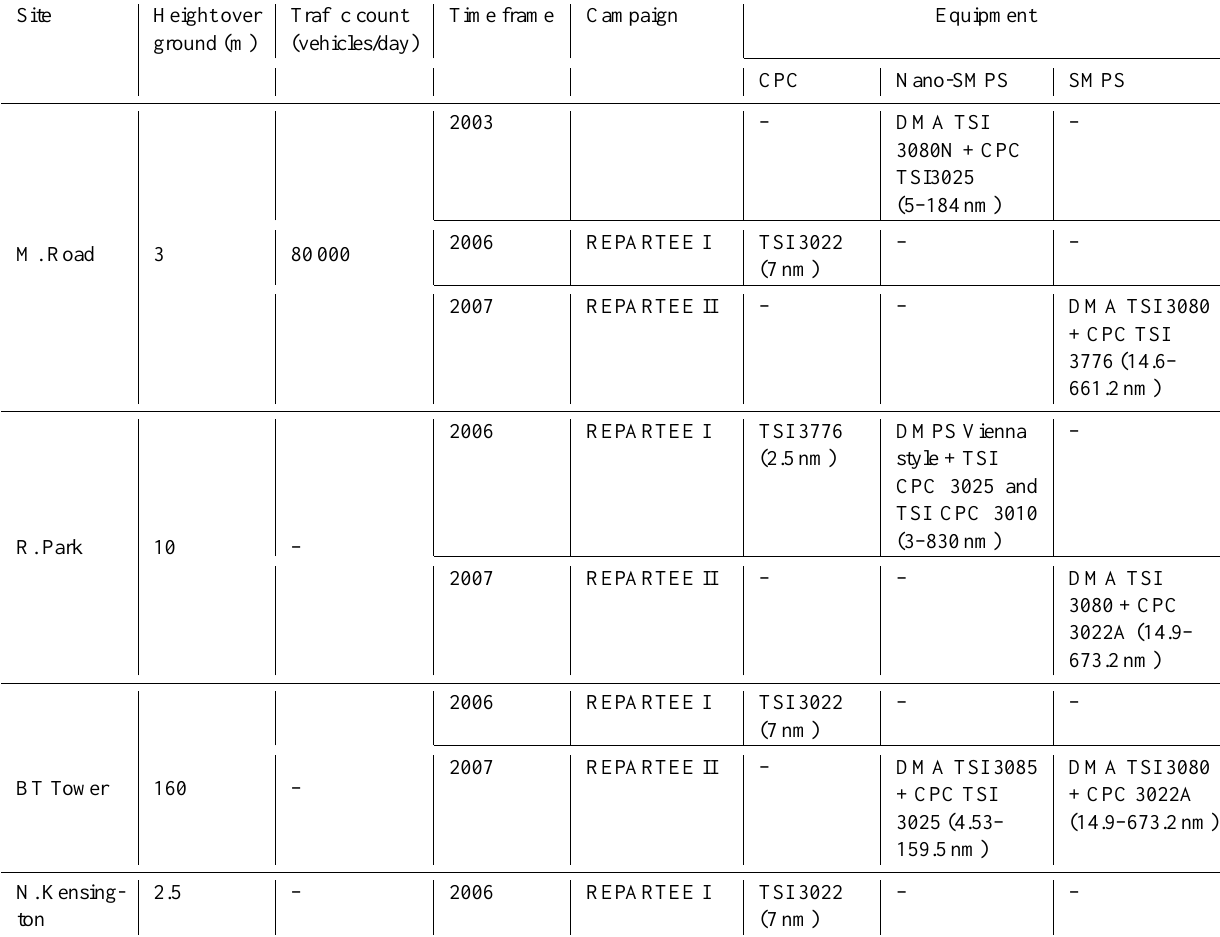
Table 1. Summary of instruments used in this